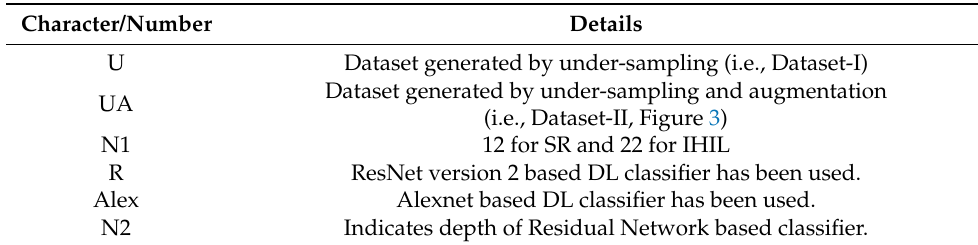
Table 3. The terminology of the test cases.